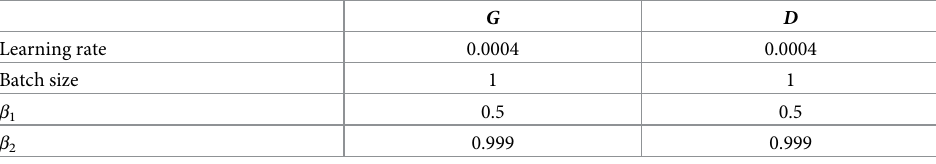
Table 1. Hyperparameters of the image translation neural network.